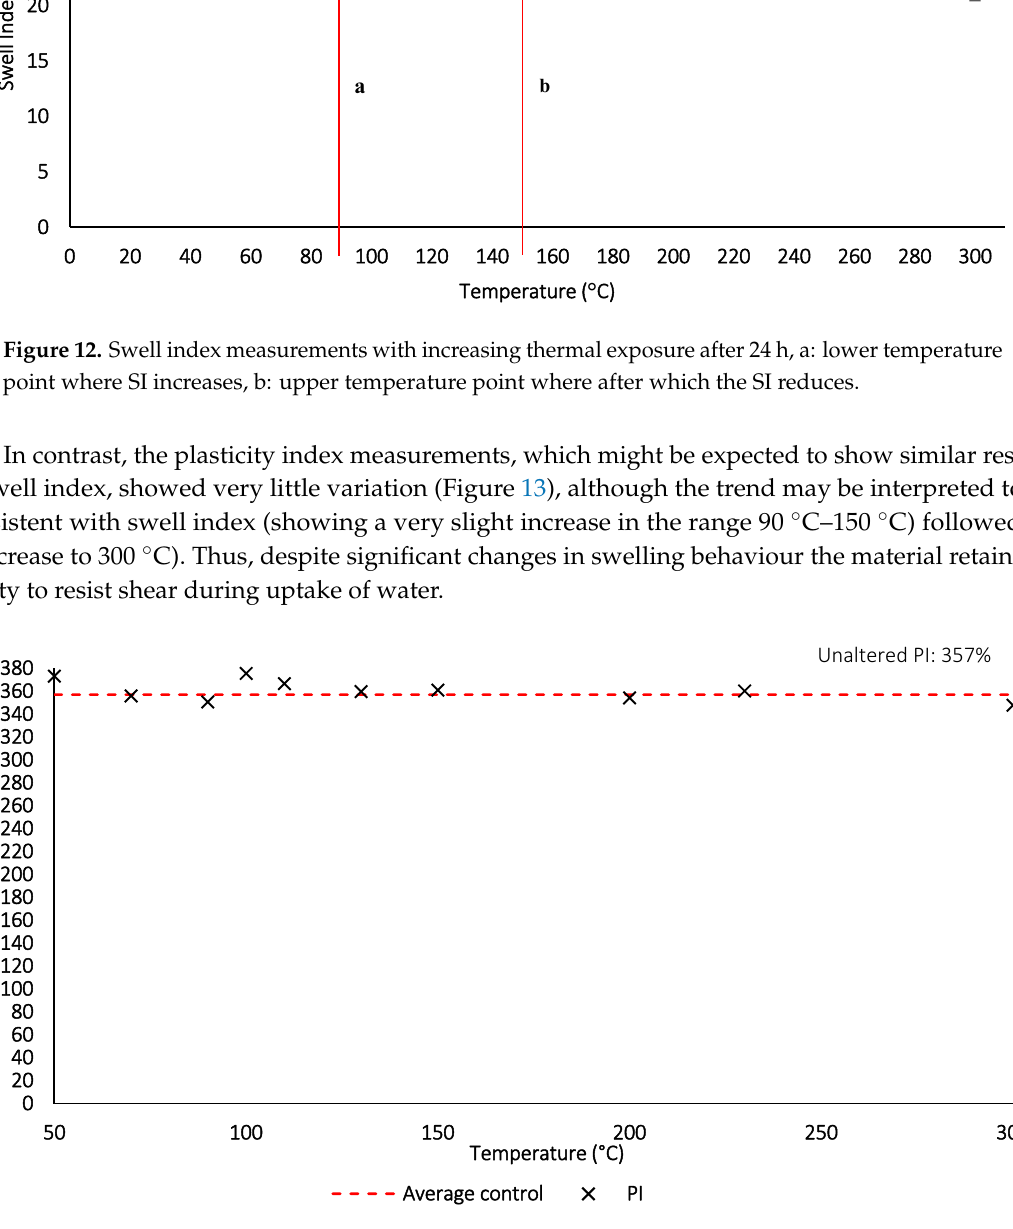
Figure 13. Plasticity index with increasing thermal exposure for 24 h.